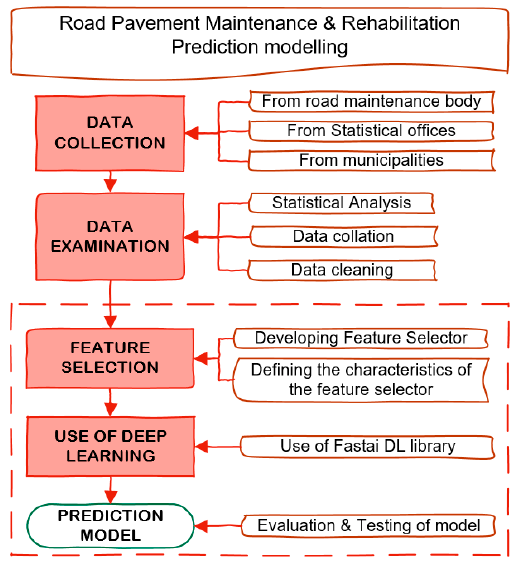
Figure 2. Workflow for study.